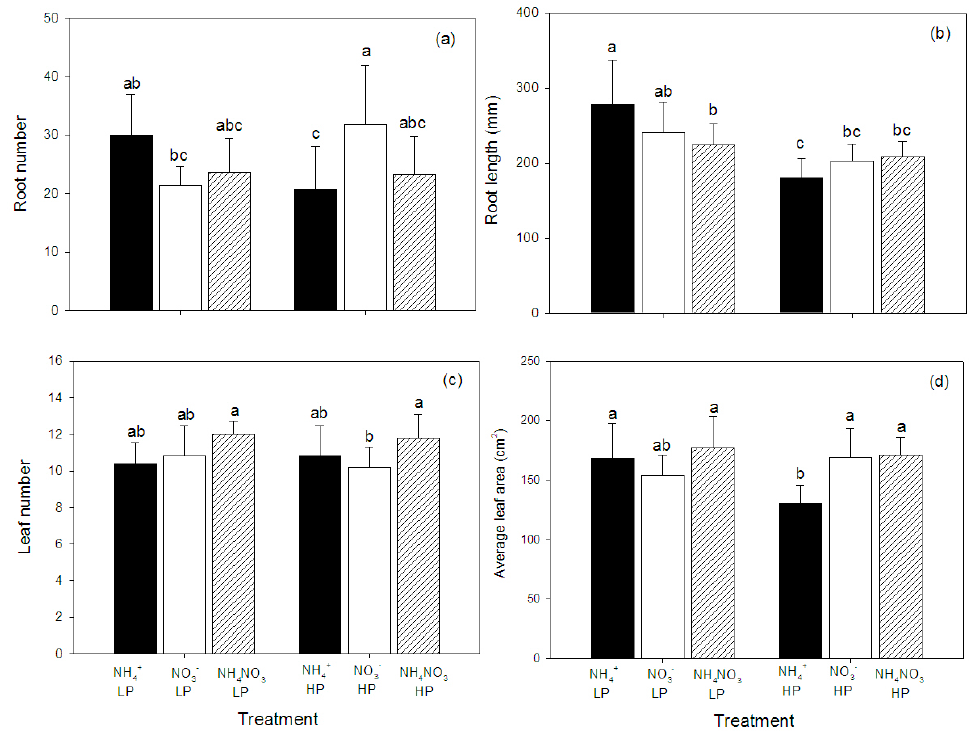
Figure 2. Root number ( a ), root length ( b ), leaf number ( c ), and average leaf area ( d ) of hybrid Napier grass ( Pennisetum purpureum × P. americanum ) (mean ± SD) grown on different N forms (NH 4+ , NO 3 − , and NH 4 NO 3 ) and P concentrations (LP, low P concentration (100 µM P); HP, high P concentration (500 µM P)). Different letters above columns indicate significant differences between treatments.